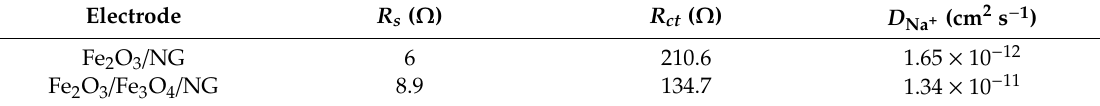
Table 1. The fitted EIS parameters and di ff usion coe ffi cients of Fe 2 O 3 / NG and Fe 2 O 3 / Fe 3 O 4 / NG.